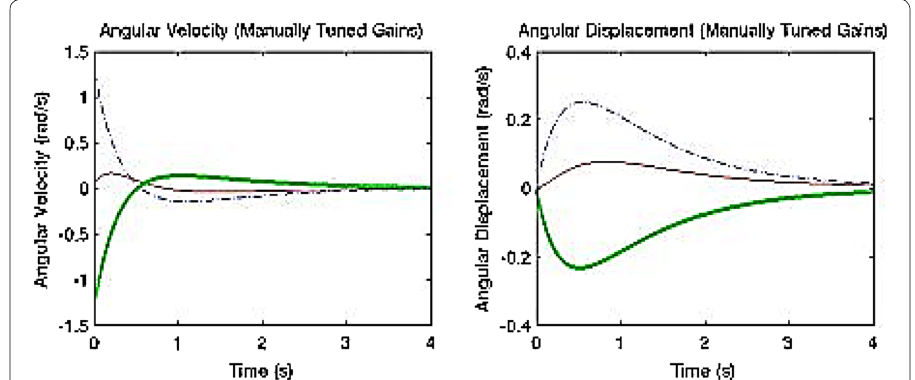
Fig. 4 Manual generated graph of angular velocities and displacement